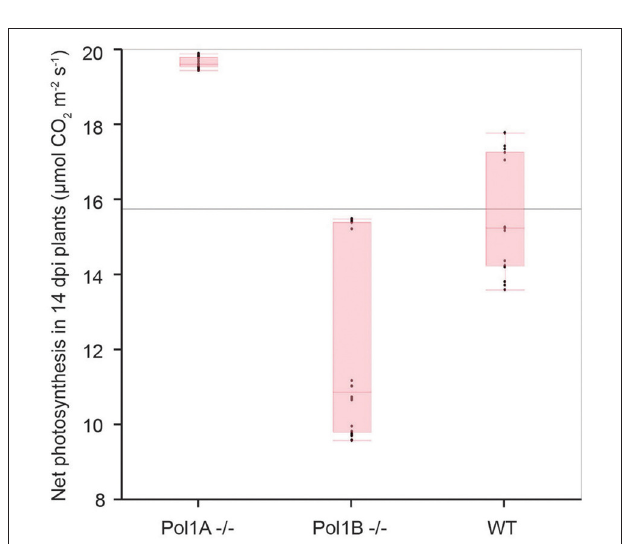
FIGURE 6 | Net photosynthetic rates in mutant plants. Observed photosynthesis rates appear to increase in Pol1A − / − mutants.